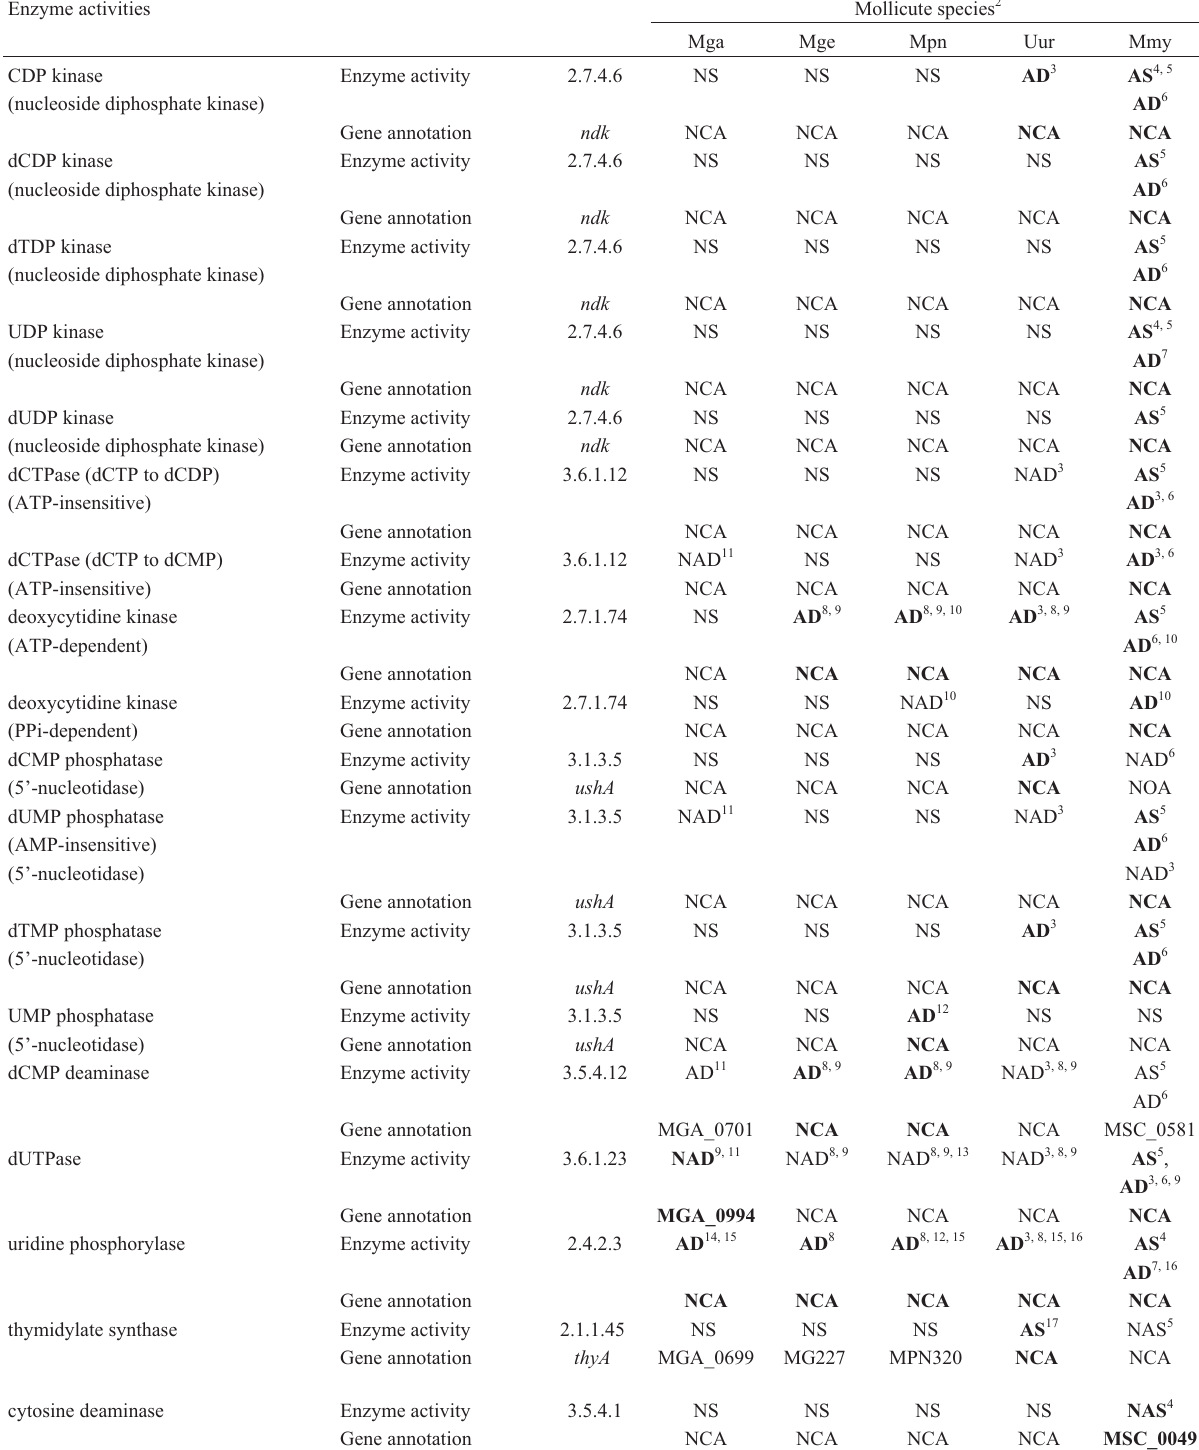
Table 2 - Differences between enzyme activity assays and gene annotation in pyrimidine nucleotide metabolism 1